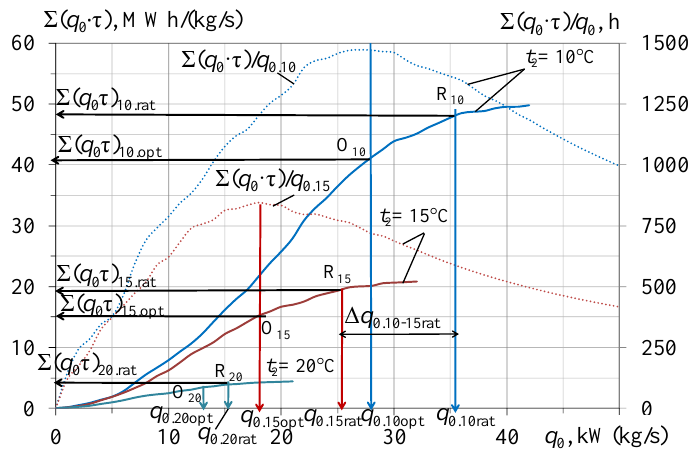
Figure 1. Specific annual refrigeration energy consumption ∑ ( q 0 · τ ), rational q 0.rat and optimal q 0.opt refrigeration capacities while conditioning air to t a 2 = 10, 15 ◦ C and 20 ◦ C: LL 10rat = ( q 0.10rat − q 0.15rat )/ q 0.10rat .